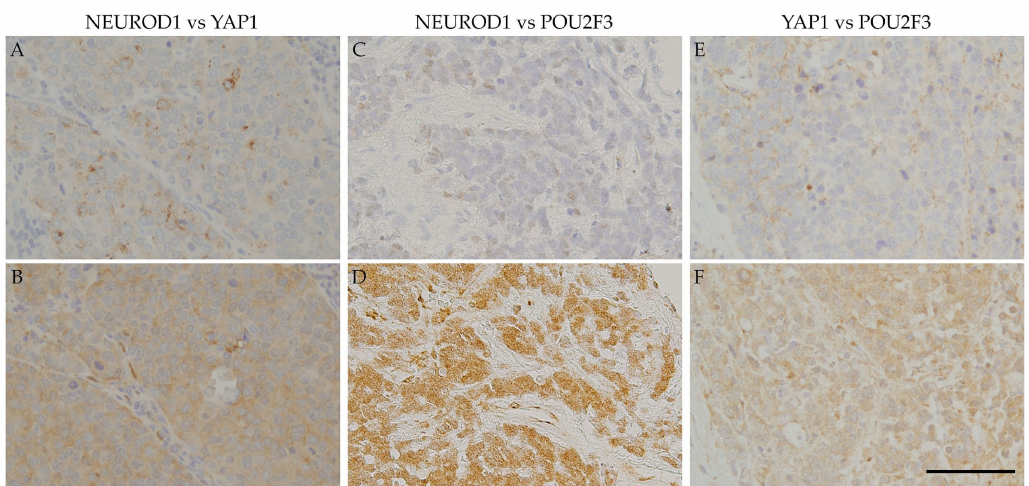
Figure 3. IHC of the co-expression of key molecules other than ASCL1 in SCLC samples. Serial section immunostaining for NEUROD1 ( A ) and YAP1 ( B ): SCLC cell nuclei were positive for NEUROD1 ( A ), and the cytoplasm was positive for YAP1 ( B ). Serial section immunostaining for NEUROD1 ( C ) and POU2F31 ( D ): SCLC cell nuclei were positive for NEUROD1 ( C ), and the cytoplasm was positive for POU2F3 ( D ). The cytoplasm of SCLC cells was positive for YAP1 ( E ) and POU2F3 ( F ). Scale bar = 100 µ m. Table 5. Candidate target molecular expression in ASCL1-positive and ASCL1-negative samples. ASCL1-Positive ASCL1-Negative p -Value Antibody Low Medium High Low